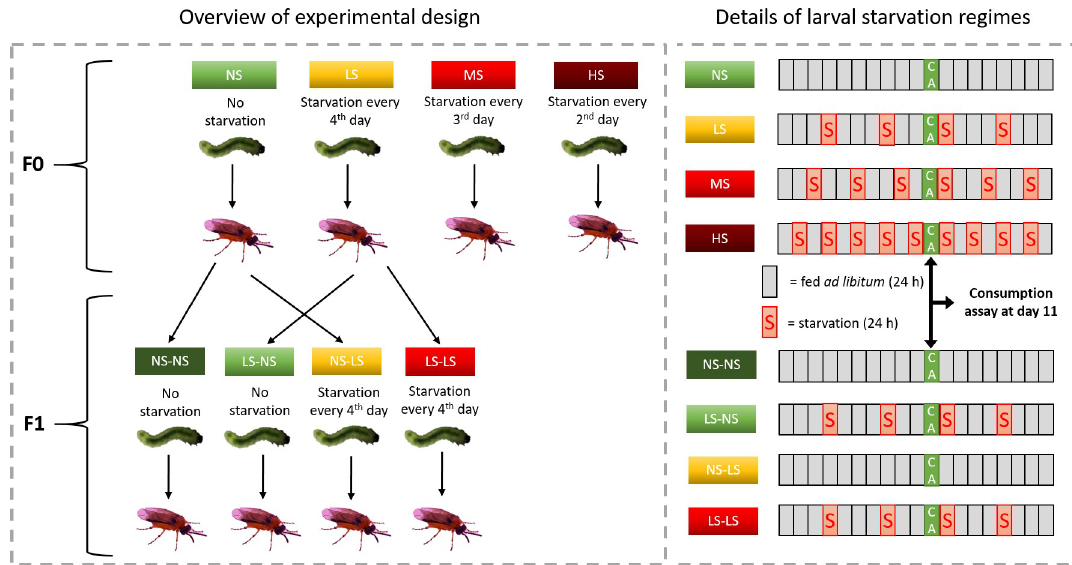
Fig 1. Scheme of the experimental set-up. Larvae of the F0-generation were assigned to four different treatments. F1-individuals from the no starvation (NS) and low starvation (LS) treatment were assorted to either of these two treatments in a match-mismatch design (left). Moreover, details of the starvation regimes and the timing of the consumption assay are depicted